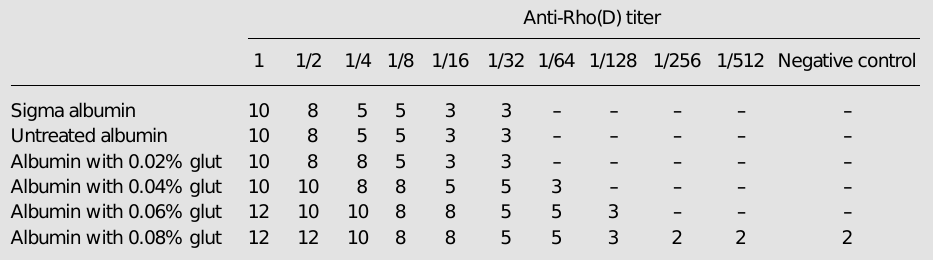
Anti-Rho(D) titer